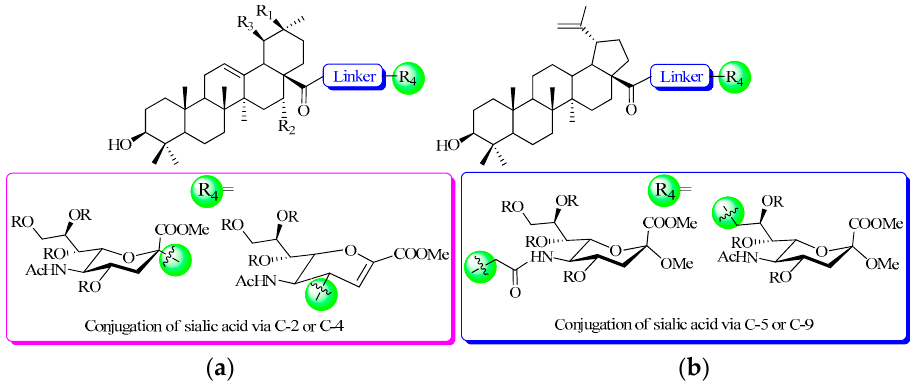
Figure 1. The structures of novel pentacyclic triterpene-sialic acid conjugates: ( a ) From previous work [25,26]; ( b ) In this work.